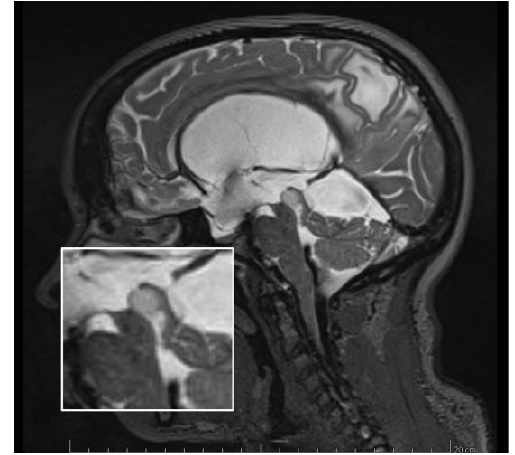
Figure 4 - Focal tumor (Type II) of the quadrangle lamina with hydrocephalus, submitted to VTE – Sagittal T2 Dorsally Exophytic Brainstem Tumors (Exophytic tumors) – (Type III) The dorsally exophytic subtype accounts